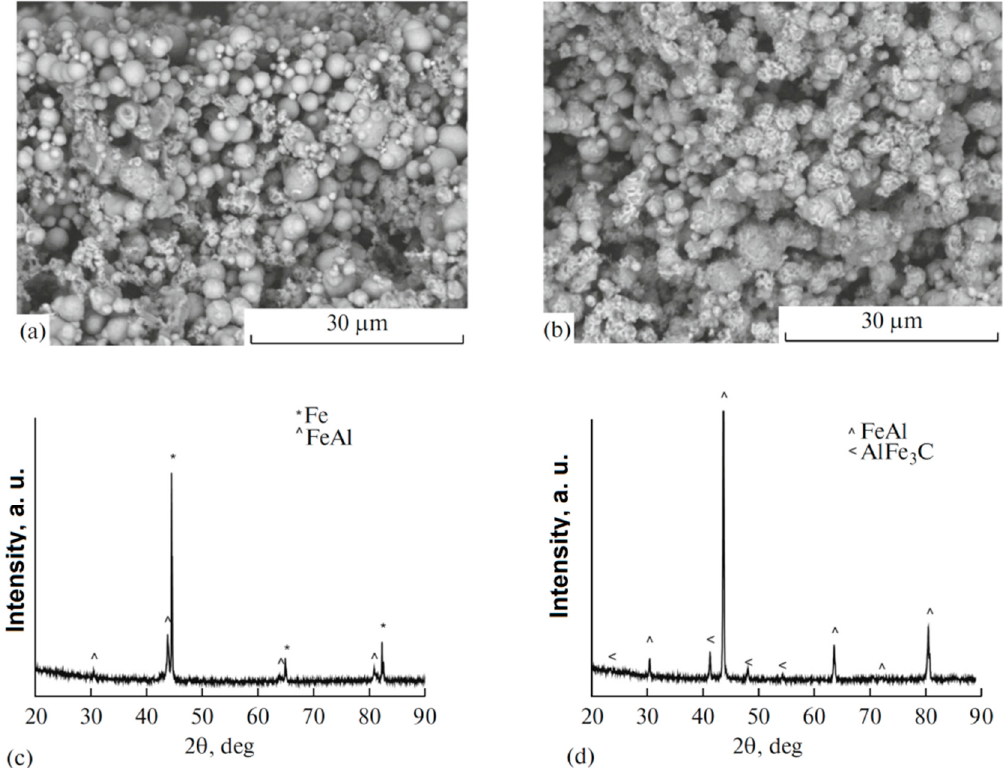
Figure 18. Fracture surface of the compact formed from a mixture of Fe and Al powders by pressureless SPS at 650 °C for 3 min, the top of the sample was not contacting the tooling: ( a ) in the vicinity of the top of the sample, ( b ) in the vicinity of the bottom; XRD patterns taken from the top ( c ) and bottom ( d ) of the sample. AlFe 3 C is an admixture phase formed due to the presence of carbon in the starting iron powder. Reprinted from Dudina [48], Copyright (2017), with permission of Springer Nature.